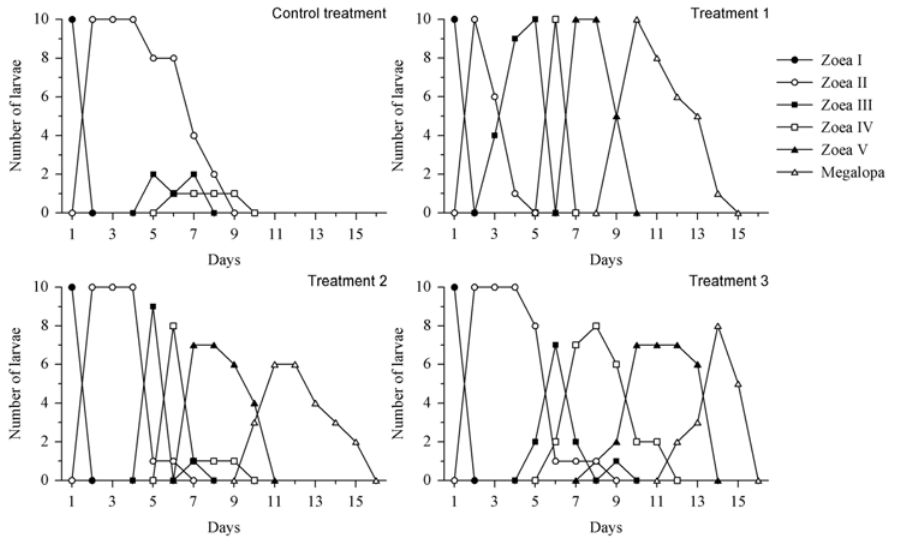
Fig. 3 – Number of surviving larvae of each stage during cultivation of Callichirus major submitted to an initial period of starvation. Control treatment: larvae were submitted to entire starvation; Treatment 1: larvae were starved for 1 day only; Treatment 2: larvae were starved for 2 days; Treatment 3: larvae were starved for 3 days.